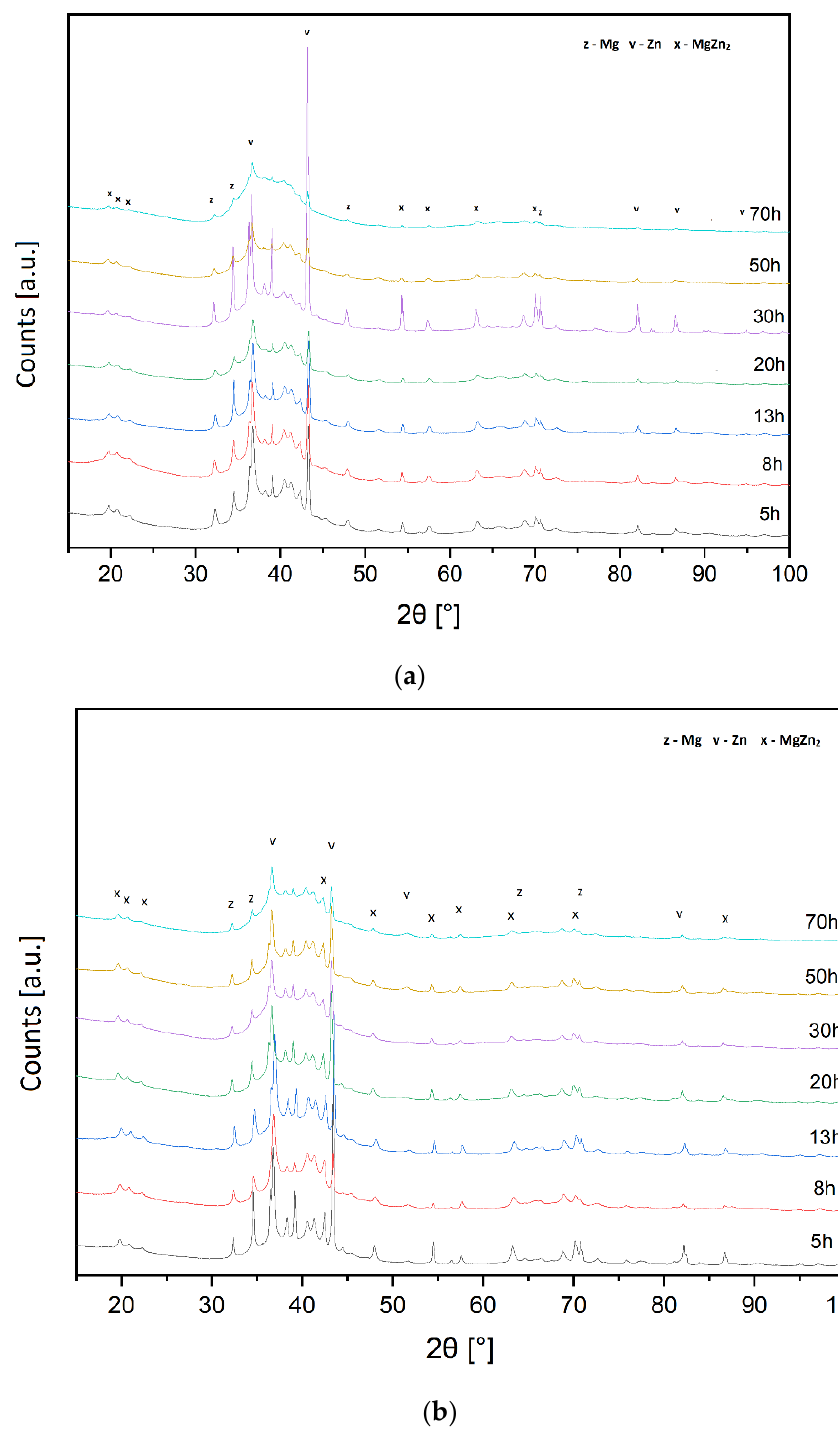
Figure 2. ( a ) The X-ray diffraction patterns of the Ag1 (Ag1 = 1 at.% of Ag) alloy obtained after various milling times (5, 8, 13, 20, 30, 50, 70 h). ( b ) The X-ray diffraction patterns of the Ag2 (Ag2 = 2 at.% of Ag) alloy obtained after various milling times (5, 8, 13, 20, 30, 50, 70 h). Table 1. Chemical composition (atomic and weight concentration) of alloys (powder weight = 10 g). Alloy